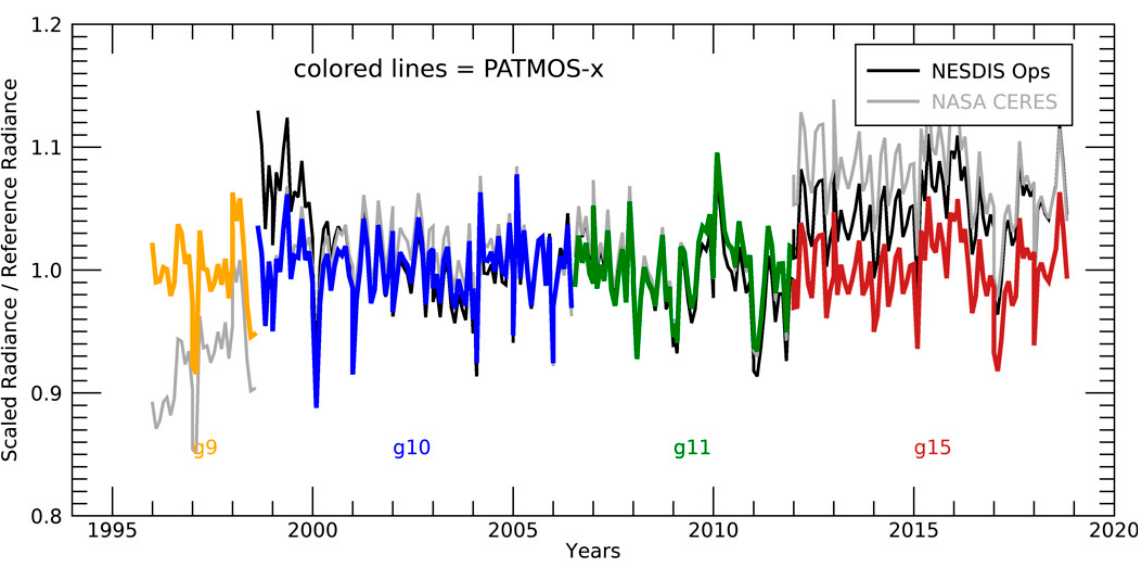
Figure 8. Same as Figure 7, but for